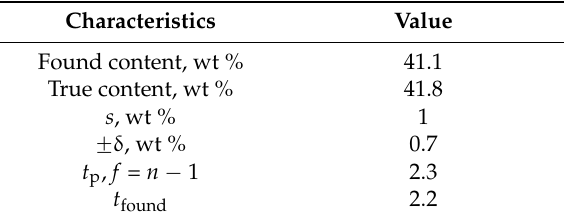
Table 1. Metrological characteristics of the Elementar’s procedure.